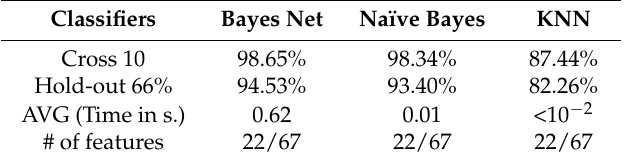
Table 17. Results using Info Gain Attribute Select of all feature for IAM Online Handwriting